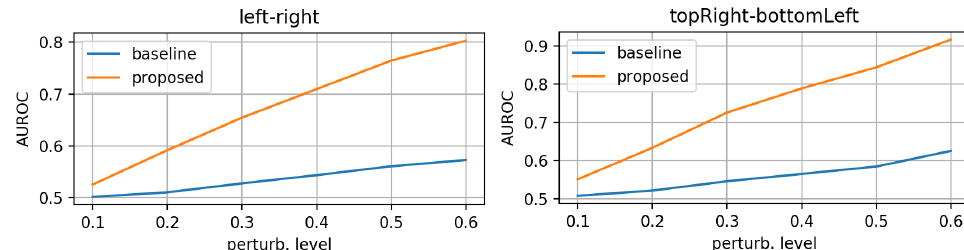
Figure 8. AuRoC performance for the baseline and proposed architecture when tested against mask morphing in various directions. Training done only on original